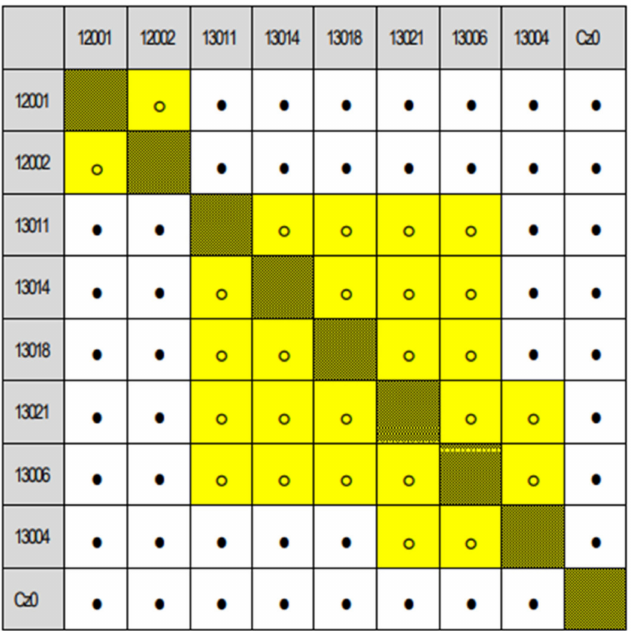
Figure A6. Matrix of significance of population mean height differences of the trial Dražiˇcky, ordered by the group average of mean heights (best in top left).